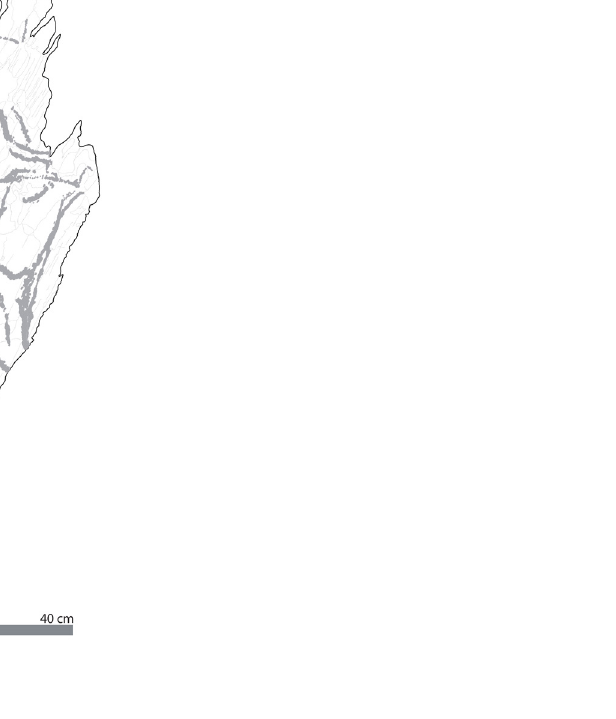
Figure 12. Motifs on Penascosa Rock 4, Côa Valley, Portugal. Tracing: Mário Varela Gomes, assisted by João Félix and Cristina Gaspar.